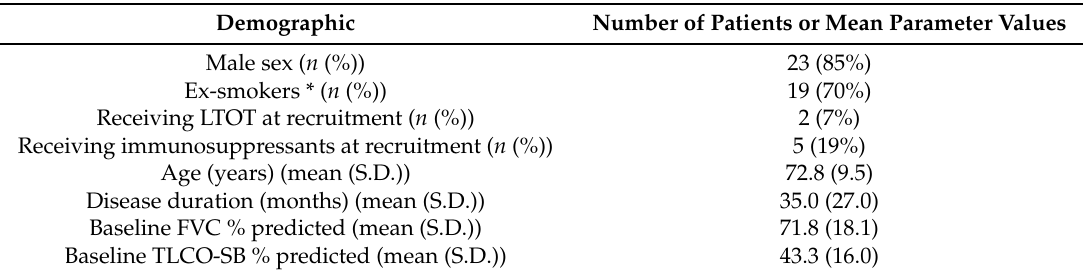
Table 1. Summary table of patient demographics and baseline lung function.